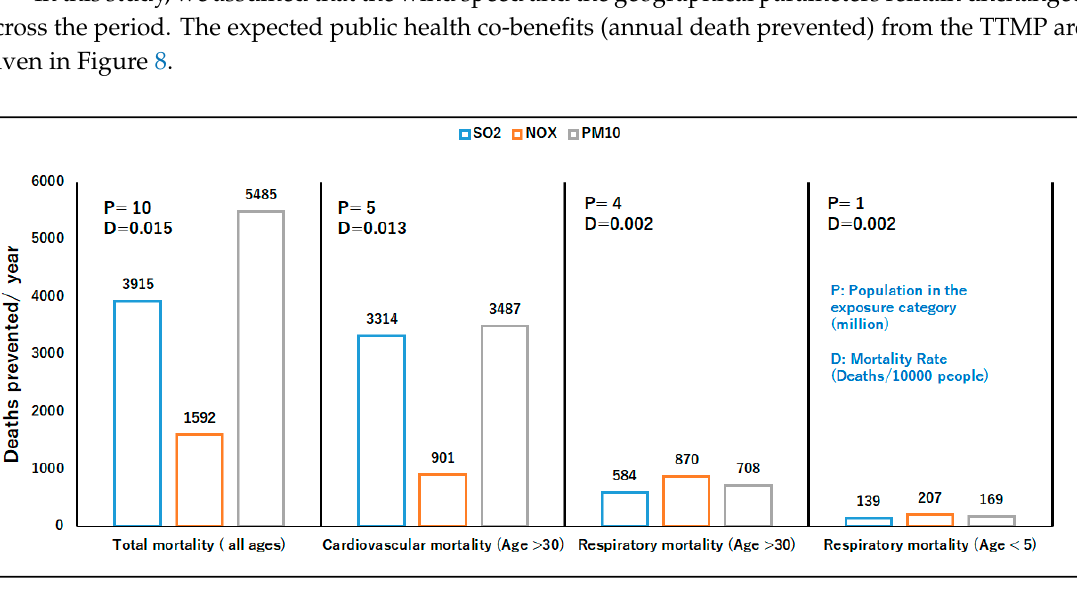
Figure 8. Expected public health co-benefits from the TTMP in 2030 (1. Data collected from the Ministry of Health and Medical Education for 1990–2013 [61]. 2. The respiratory disease mortality rate for children under five years was collected from [62]).